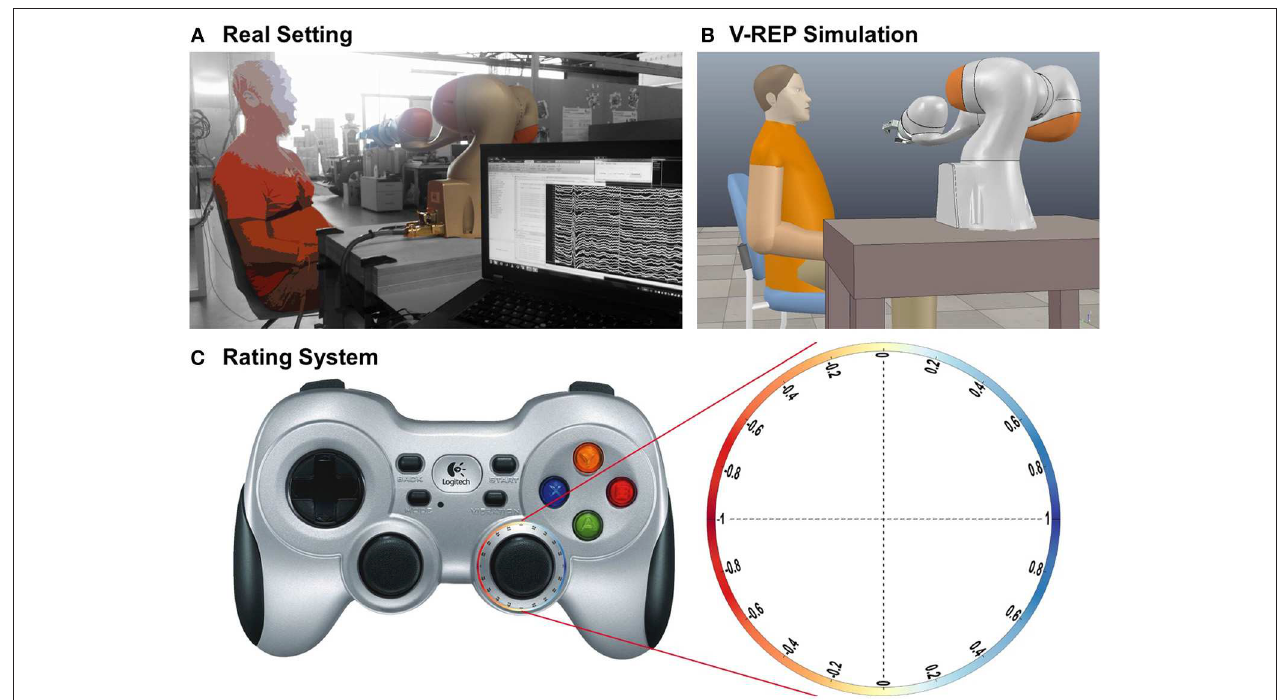
FIGURE 2 | Paradigm setting, reconstruction, and rating system. (A) Photograph of the real setting. The picture was edited to make the user anonymous and to display the background in black and white. (B) Reconstruction in V-REP. (C) Robot behavior rating system with a wireless controller. The users rated the robot’s behavior within a continuous range from − 1 to 1. To do that, the users had to keep a thumbstick on a wireless controller on an outward circular path with their right thumb, where a left position represented a very bad rating ( − 1, red), a position to the right represented a good rating (1, blue), and a position straight up or down represented a neutral rating (0, yellow). This system was introduced so that the movement effort for the thumb was the same at each position, making an EEG analysis